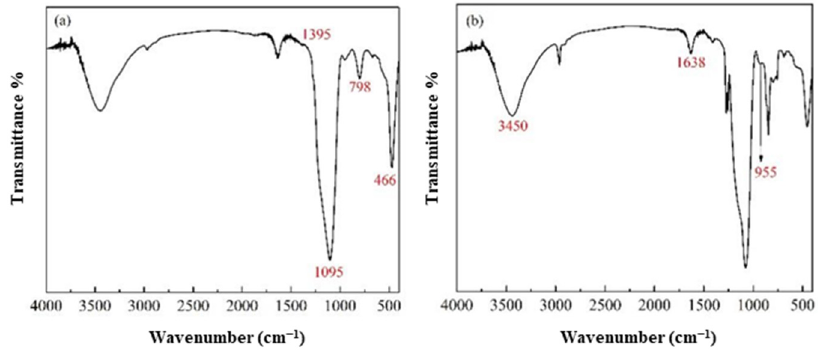
Figure 2. The FT-IR spectrum of SiO 2 aerogel power before ( a ) and after ( b ) modification.